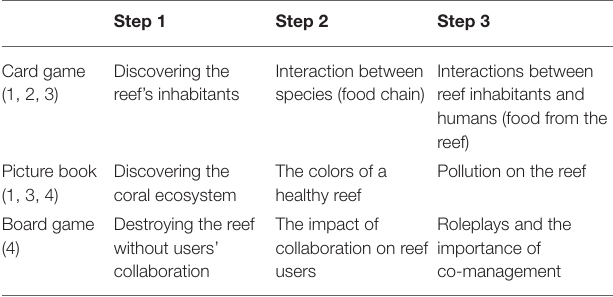
TABLE 2 | Different steps of games during the protocol before the teaching toolbox MARECO is left with the classes; and the messages associated with the games (1: The coral is alive; 2: The reef is a place of high biodiversity; 3: The reef is a whole; species interact with each other and the environment, including humans; 4: Humans are part of the system; they interact with others species, and enjoy, break, repair and protect the coral reef ecosystem that provide many